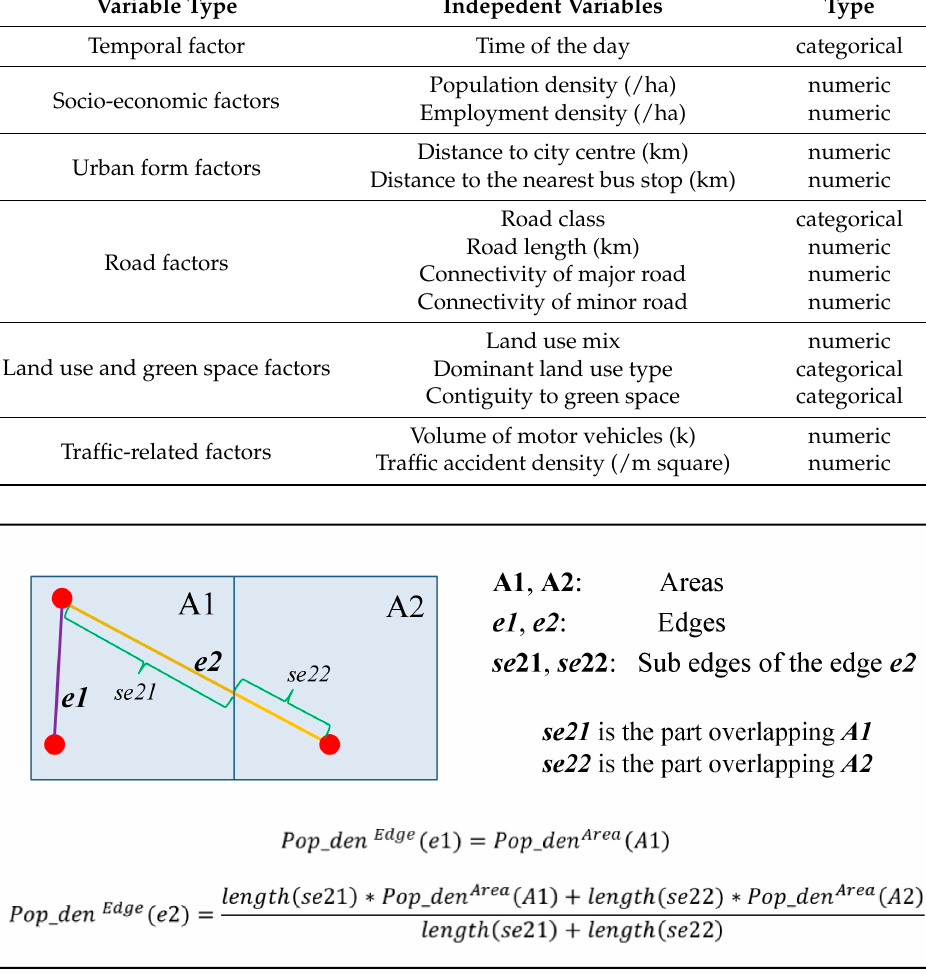
Figure 2. A simple example for calculating the population density of a street.